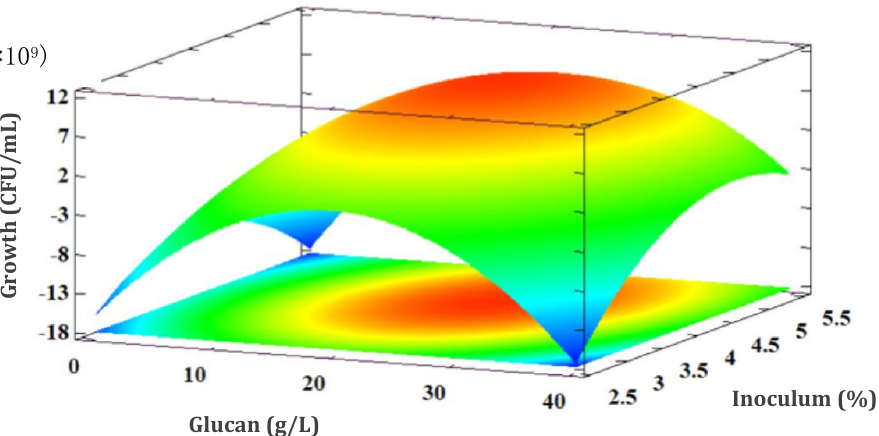
Figure 4. Response surface derived from the combination effect of the β -glucan concentration and the percentage of inoculum over L. rhamnosus GG